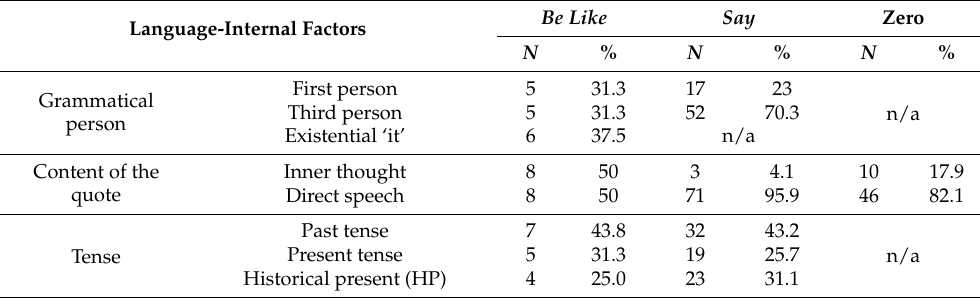
Table 8. Distribution of language-internal factors conditioning the distribution of be like among Chinese L2